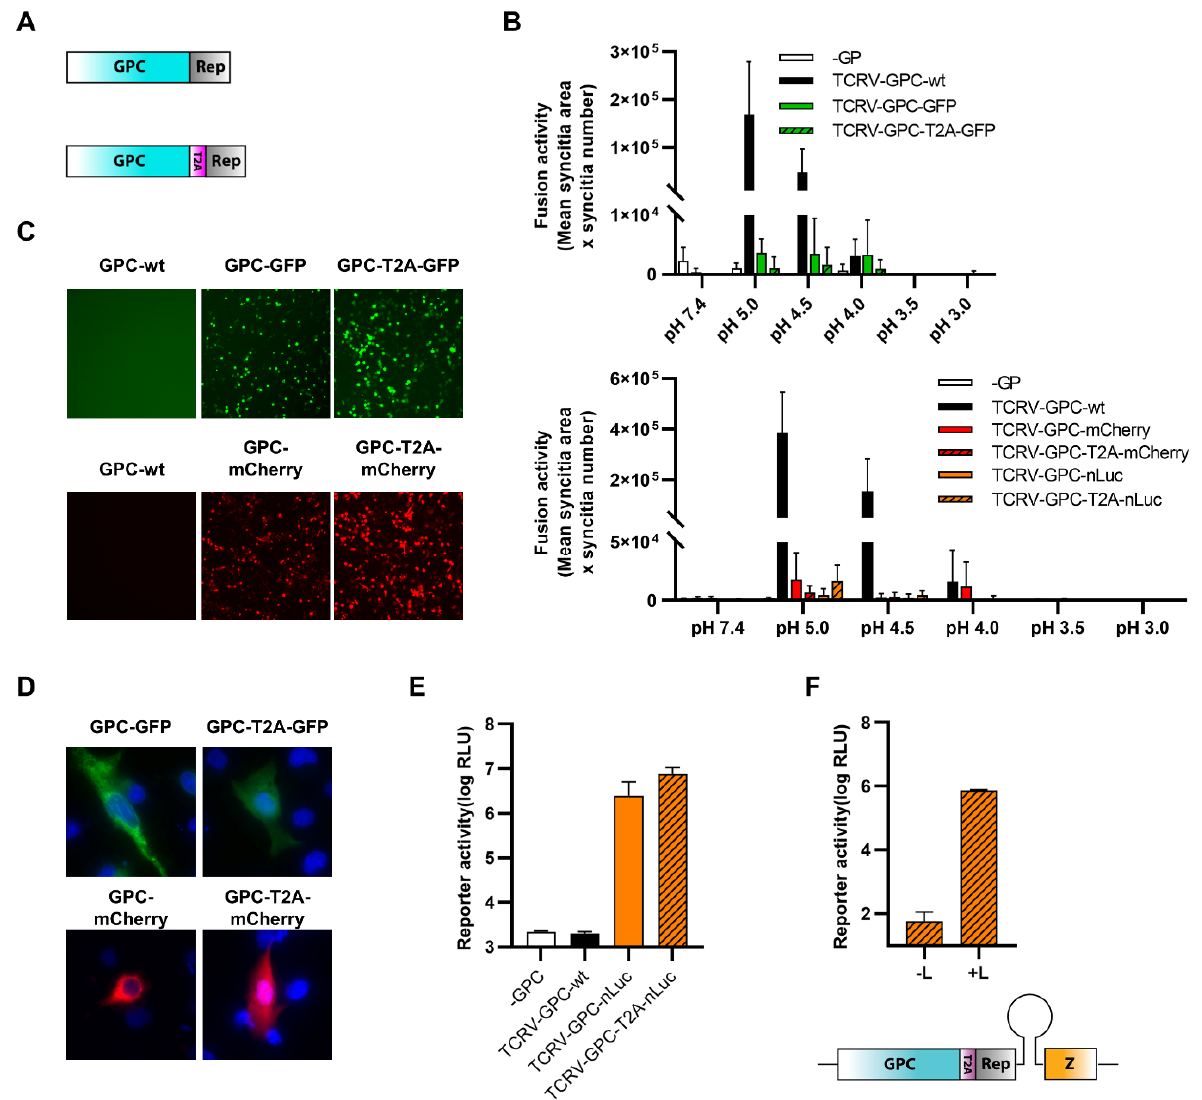
Figure 5. C-terminal fusion of TCRV GPC to reporter proteins. ( A ) Schematic. Reporter proteins were C-terminally fused directly to TCRV GPC (top) or separated by a T2A site (bottom). ( B ) Fusion activity. BSR-T7/5 cells were transfected with plasmids encoding mCherry, and GPC constructs fused to GFP (top) or constructs encoding GFP, and GPC constructs fused to either mCherry or nLuc (bottom). After 24 h, cells were treated at the indicated pH for 5 min at 37 °C and rinsed. Cells were fixed 24 h later and syncytia formation was measured. Results are shown as the mean ± SD of the total syncytia area from ten random fields of view from three independent experiments. ( C ) Reporter activity (GFP/mCherry). Pictures of cells transfected as in ( B ) were taken 48 h post-transfection at 10 × magnification. Results are shown as representative images from one experiment out of two independent experiments. ( D ) Reporter localization. Pictures of cells transfected as in ( B ) were taken 24 h post-transfection at 63 × magnification after fixation and DAPI staining. Results are shown as representative images from one experiment out of two independent experiments. ( E ) Reporter activity (nLuc). Cells transfected as in ( B ) were lysed 48 h post-transfection, and nLuc activity in lysates was measured. Results are shown as mean ± SD of three independent experiments. ( F ) trVLP entry. BSR-T7/5 cells were transfected with plasmids encoding the T7 polymerase, TCRV L, TCRV NP, and FLuc (as a transfection control), in addition to a plasmid encoding for the bicistronic minigenome. trVLPs were harvested 72 h post-transfection and were used to infect Huh7 cells that were